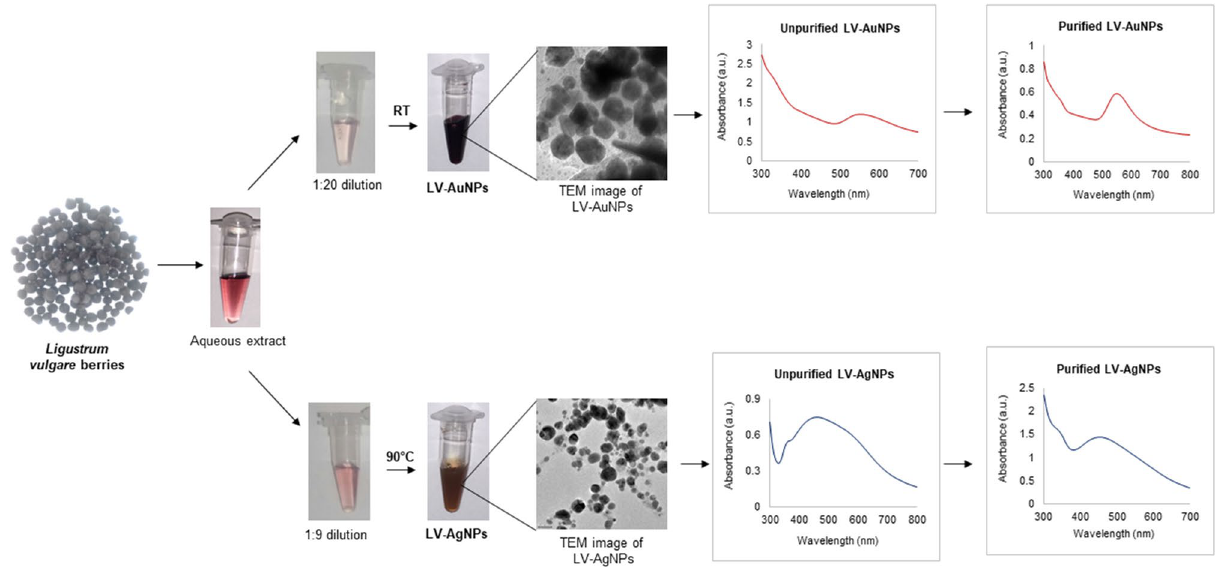
Figure 1. Schematic representation and UV-vis spectra of LV-AuNPs and LV-AgNPs formation form aqueous extract of L. vulgare berries.